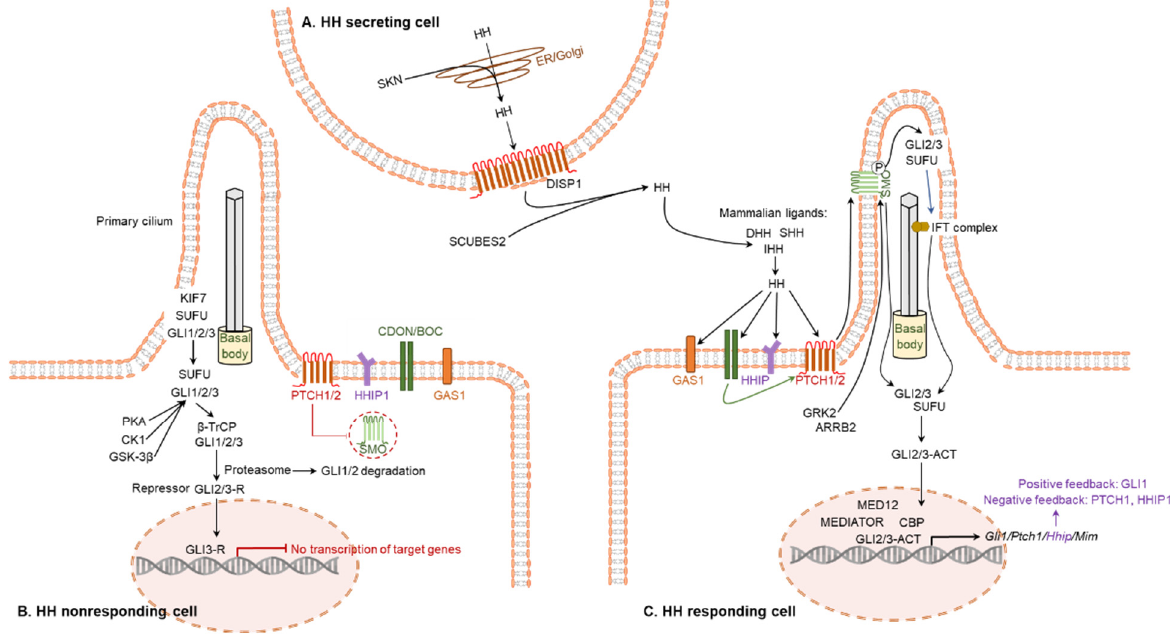
Figure 4. Canonical hedgehog signaling pathway. ( A ) The active form of HH molecules are secreted from the HH expressing cells. ( B ) In the absence of HH ligand, PTCH inhibits SMO. This is associated with GSK-3 β , CK1, and PKA-mediated phosphorylation of GLI, which forms a truncated form of GLI repressor. The repressor GLI translocates to the nucleus in order to inhibit the transcription. ( C ) Active form of HH ligand binds to PTCH receptor on the responding cells and the HH ligand-dependent interaction with PTCH and SMO results in release of SMO activator. SMO controls the processing of GLI factors, activate GLI, and initiate the cascade of downstream signaling pathways. Activated GLI translocates to the nucleus and initiates the transcription of HH target genes.